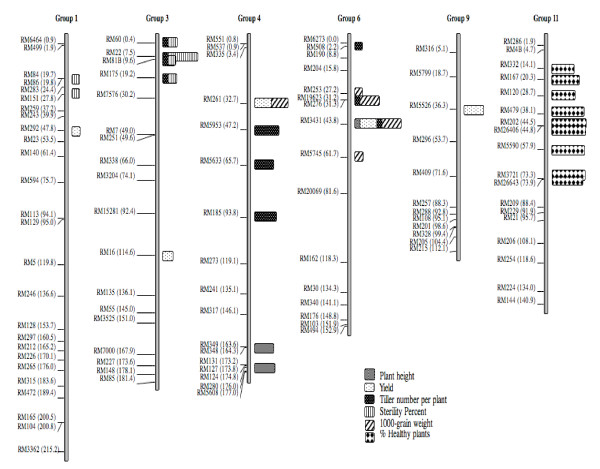
Genetic locations of the 15 QTLs for yield components an RSNV resistance (% Healthy plants) detected in this work. On the left, SSR marker positions and distances (cM) based on IR64/TOG5681 genetic linkage map, developed at CIAT in 2007 (our unpublished data). On the right, QTL for yield, yield components and RSNV resistance on chromosomes 1, 3, 4, 6, 9 and 11.